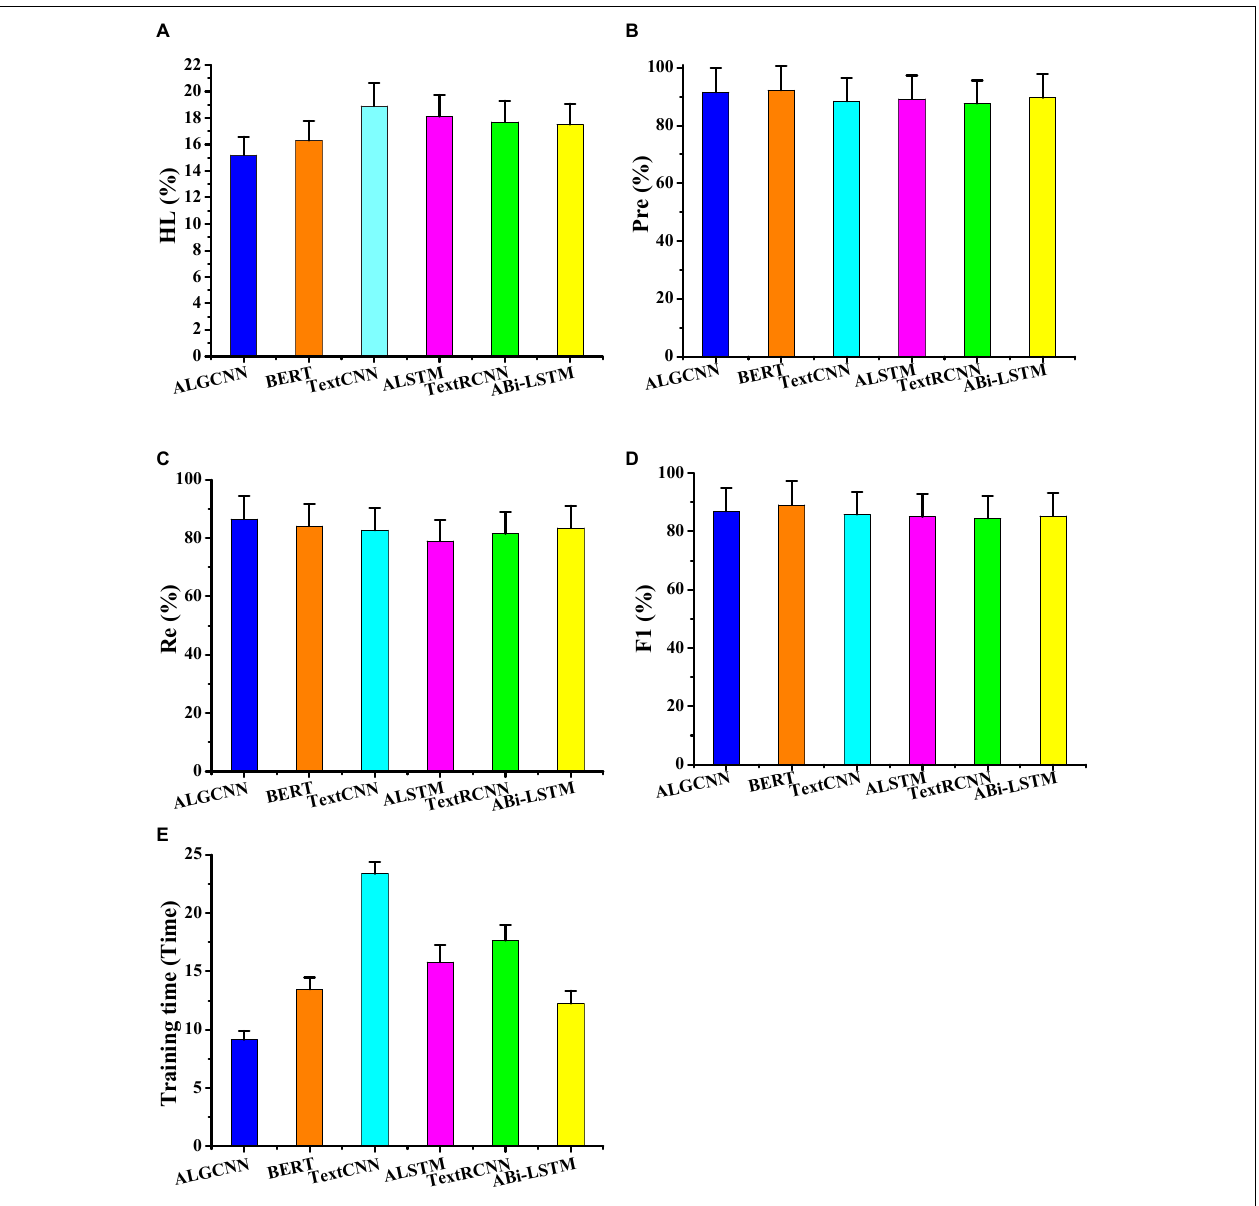
FIGURE 6 | Comparison of evaluation index values of different models. (A) Showed the comparison of the HL value; (B) showed the comparison on Pre; (C) illustrated the comparison on the Re value; (D) was the comparison on F1; and (E) showed the comparison on training time.